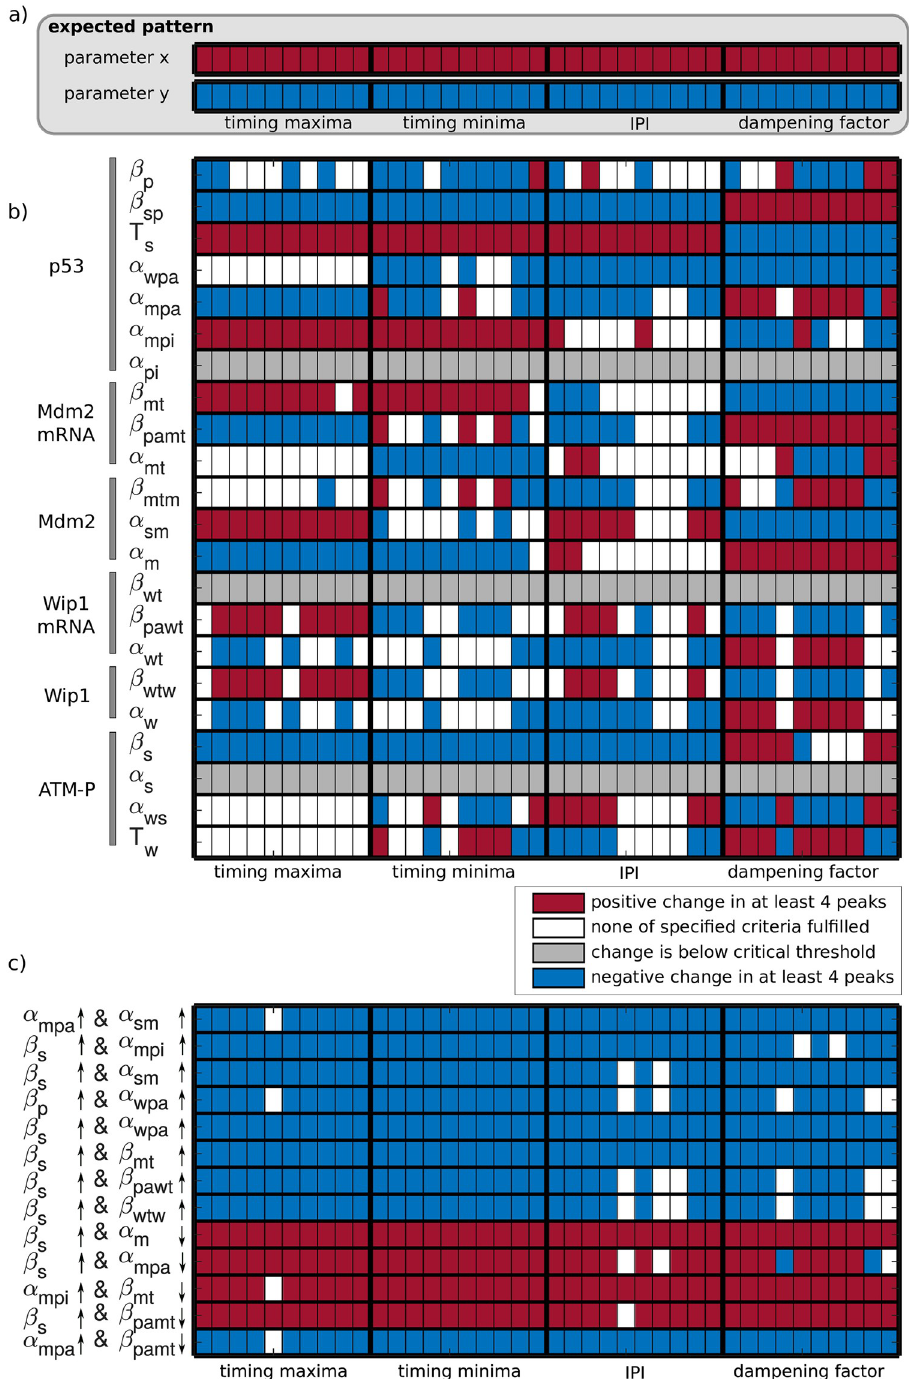
Fig 4. Sensitivity analysis predicts existence of multiple interactions of IKK2 and the p53 network. a) Expected change in features upon perturbation of a parameter, which indicates an interaction of IKK2 and the p53 network. Each box represents the effect of a parameter perturbation on a specified feature for an individual subpopulation. A red box indicates a consistent increase in the specified feature, in all considered peaks. Blue boxes represent a decrease. b) Sensitivity analysis of single parameters. If the absolute value of sensitivity coefficients of all considered peaks are below 1 � 10 − 4 , the specified parameter change has no considerable effect on the respective feature (grey boxes). Subpopulations with sensitivity coefficients of peaks which are not consistently changed are depicted in white. c) For the sensitivity analysis of parameter pairs, 13 pairs were selected from 462 possible combinations based on their